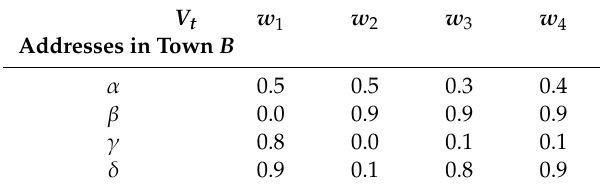
Table 6. Attribute value appurtenance fuzzy degree function for t ∈ A on Town B ( h t ).